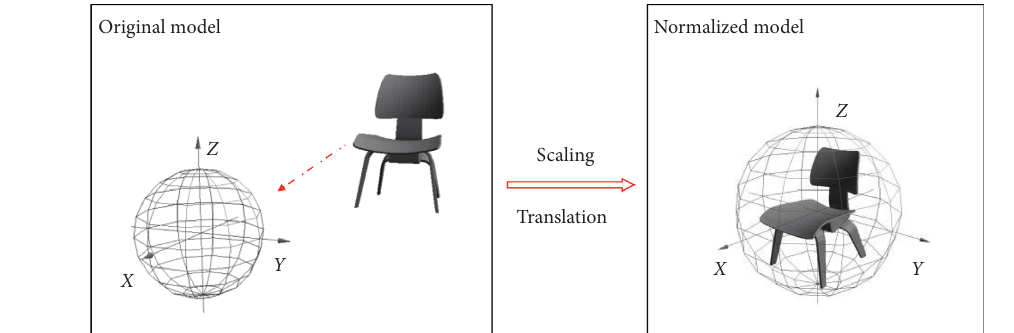
Figure 2: Model preprocessing.